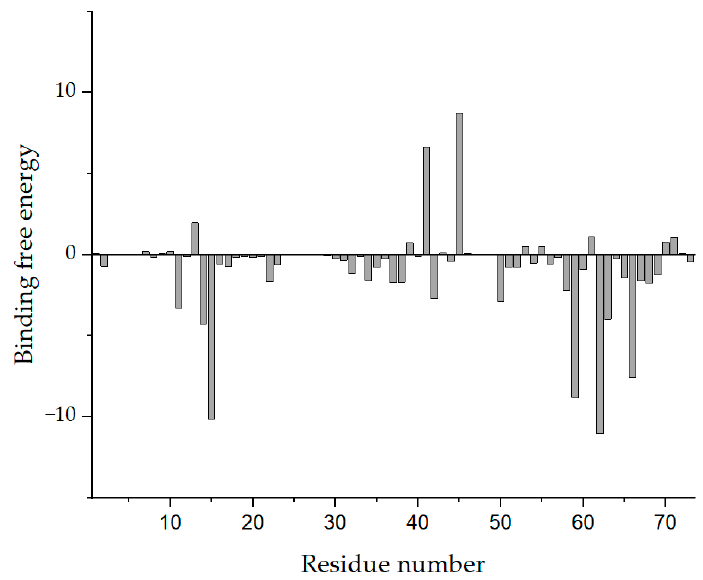
Figure 6. Analysis of the binding free energy decomposition of Compound